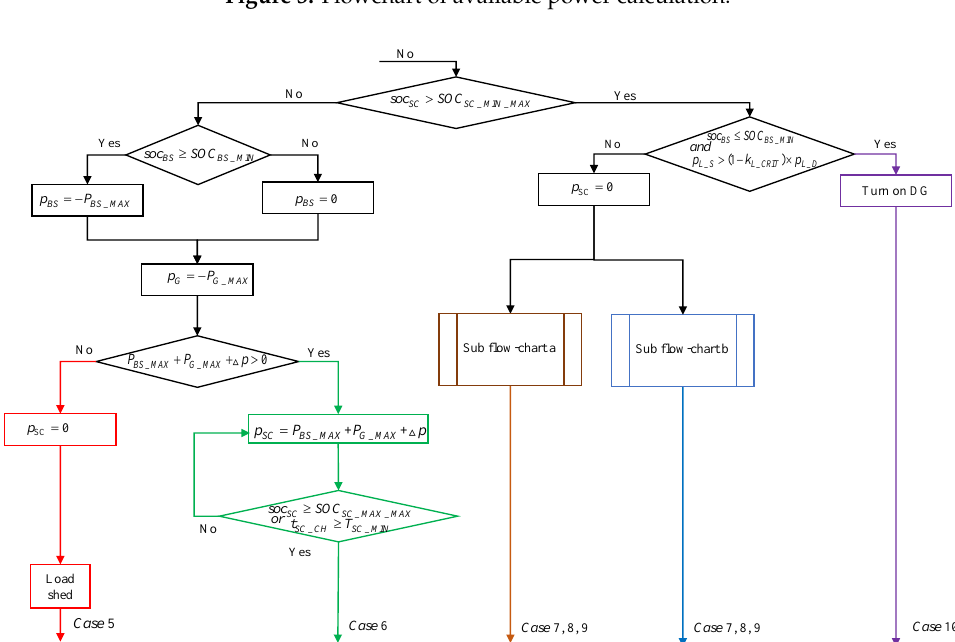
Appl. Sci. 2020 , 1 , x FOR PEER REVIEW Figure 3. Flowchart of available power calculation. Figure 3. Flowchart of available power calculation.